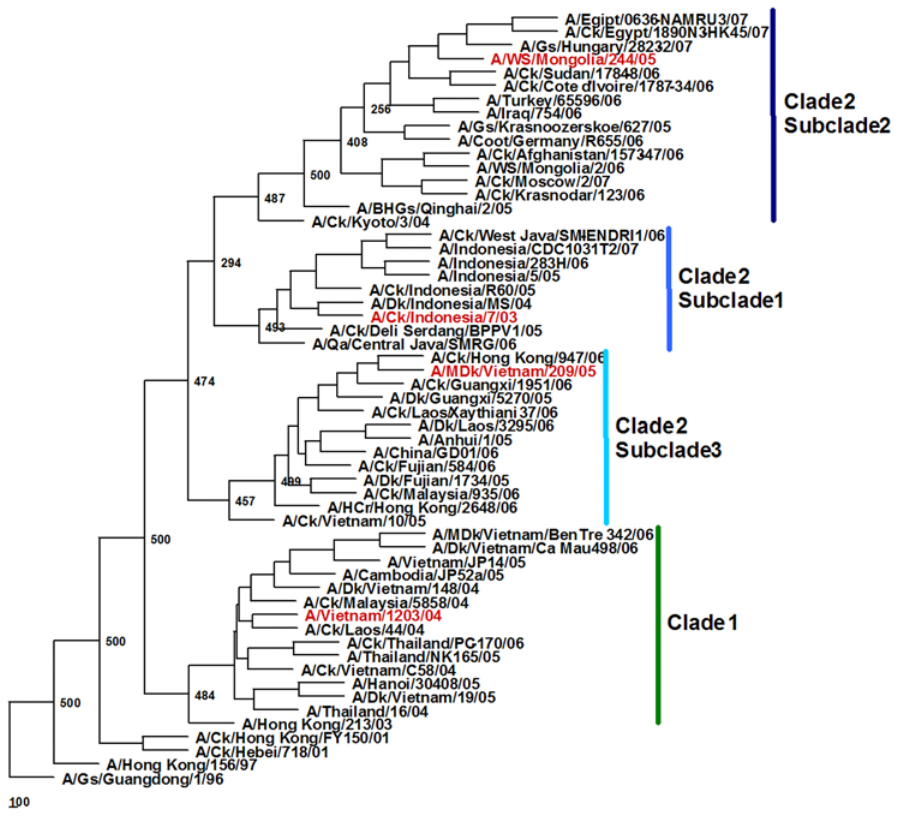
Figure 1. Phylogenetic relationships of the hemagglutinin (HA) gene of the influenza (H5N1) viruses. Sequences (nucleotides 77 to 1723) were analyzed by using the neighbor-joining method with 500 bootstraps. Phylogenetic tree was rooted to the HA gene of A/Goose/ Guangdong/1/96 (H5N1) virus. H5N1 viruses used in this study are shown in red. Abbreviations: BHGs, bar-headed goose; Ck, chicken; Dk, duck; Gs, goose; HCr, house crow; MDk, muscovy duck; Qa, quail; WS, whooper